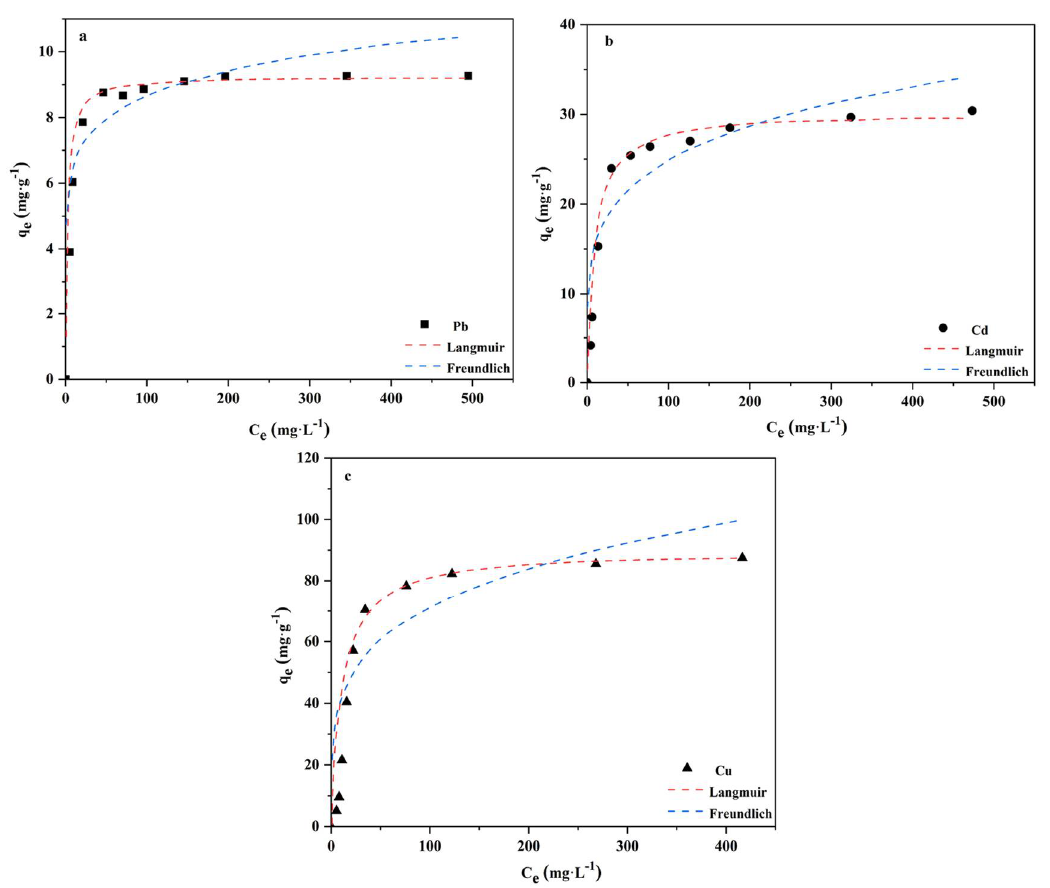
Figure 3. Isothermal lines of Pb ( a ), Cd ( b ), and Cu ( c ) after GBC adsorption. Table 3. Parameters of Freundlich and Langmuir isothermal models for Pb, Cd and Cu after GBC adsorption.